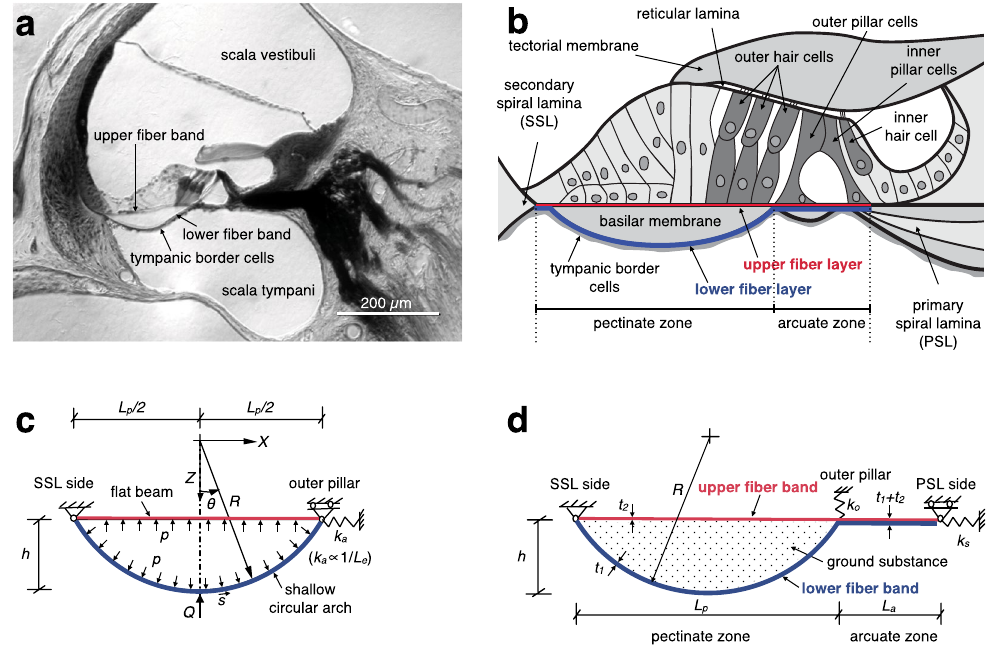
Figure 1. ( a ) Image of a gerbil cochlea, showing the large arch-shaped lower fiber band and flat upper fiber band of the BM 11 . Also visible are the tympanic border cells (TBCs) attached to the underside of the arch. ( b ) A schematic cross section of the gerbil BM and organ of Corti, showing the pectinate zone (PZ) and arcuate zone (AZ). ( c ) A simplified version of the arch–beam model (ABM) used to determine parameters of the arch without the AZ beam. Model parameters shown are point-load Q, internal pressure p, and spring stiffness k a , representing the in-plane stiffness of the AZ and the PSL. The radius of curvature R determines the degree of separation between the two fiber layers in the PZ. ( d ) Geometry of the full ABM. Model parameter k s represents the in-plane stiffness for radial displacement of the PSL and SSL and k o represents the outer-pillar support